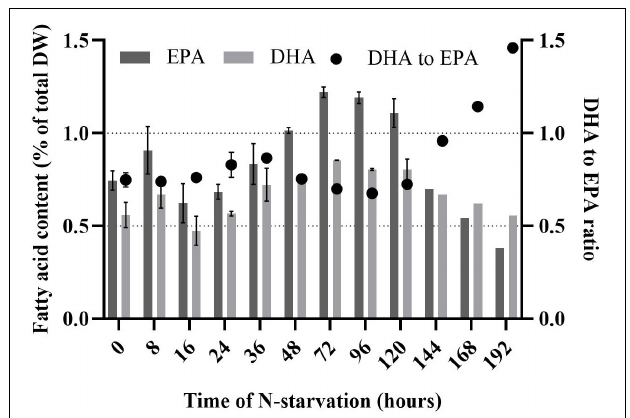
FIGURE 4 | Fatty acid concentration of Rhodomonas sp. during a 192 h N-starvation period. SFA: Saturated fatty acids, MUFA: Monounsaturated fatty acids and PUFA: Polyunsaturated fatty acids. Data are expressed as the average of three replicates ± SD. *Indicates the significant difference after ANOVA post hoc test. ns P > 0.05, *** P < 0.001.